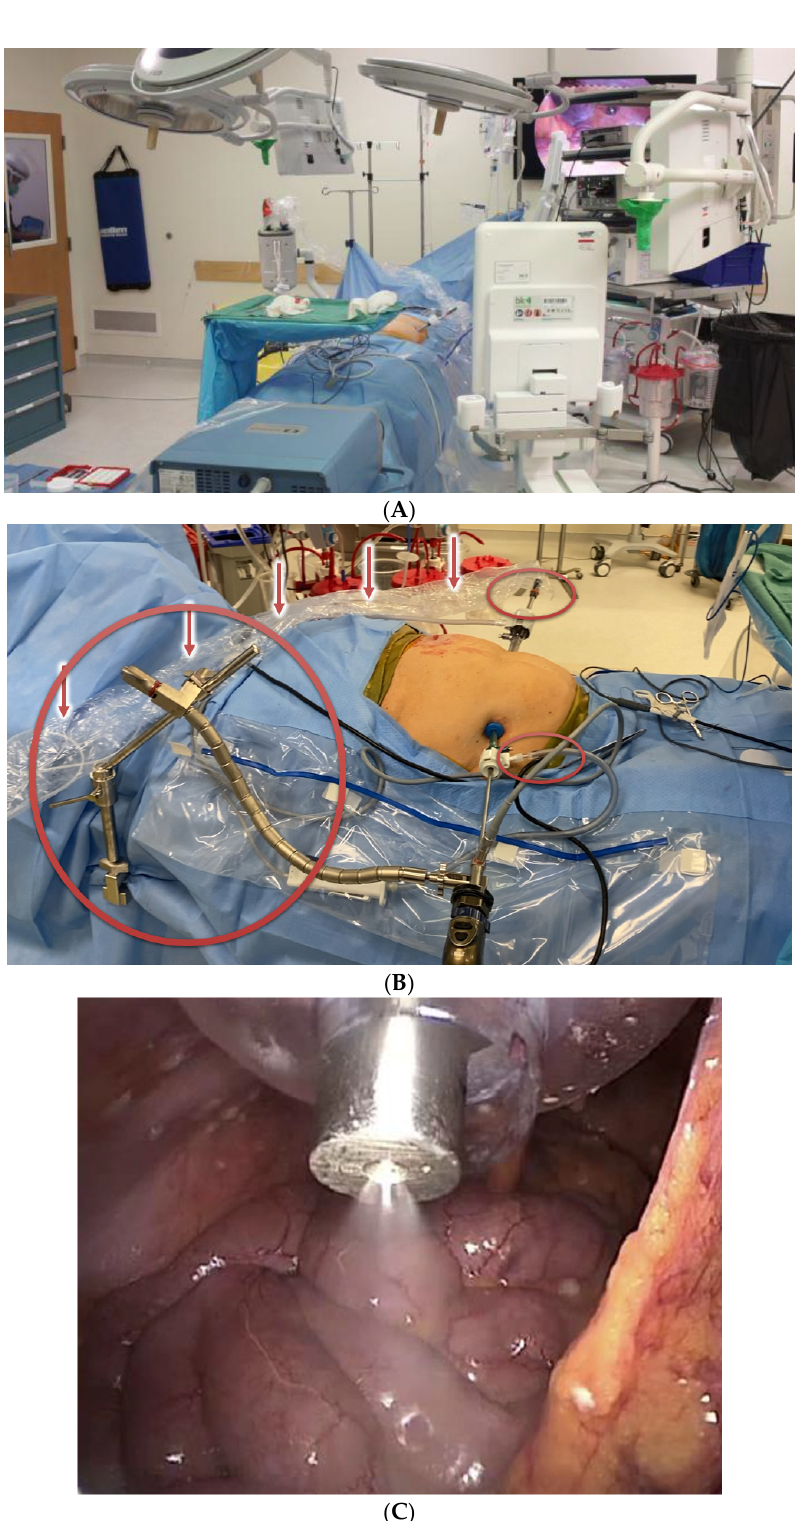
Figure 2. Intraoperative Administration of Pressurized Intraperitoneal Aerosolized Chemotherapy. ( A ): PIPAC Room Set-Up. The operating room is cleared during administration of PIPAC. Video